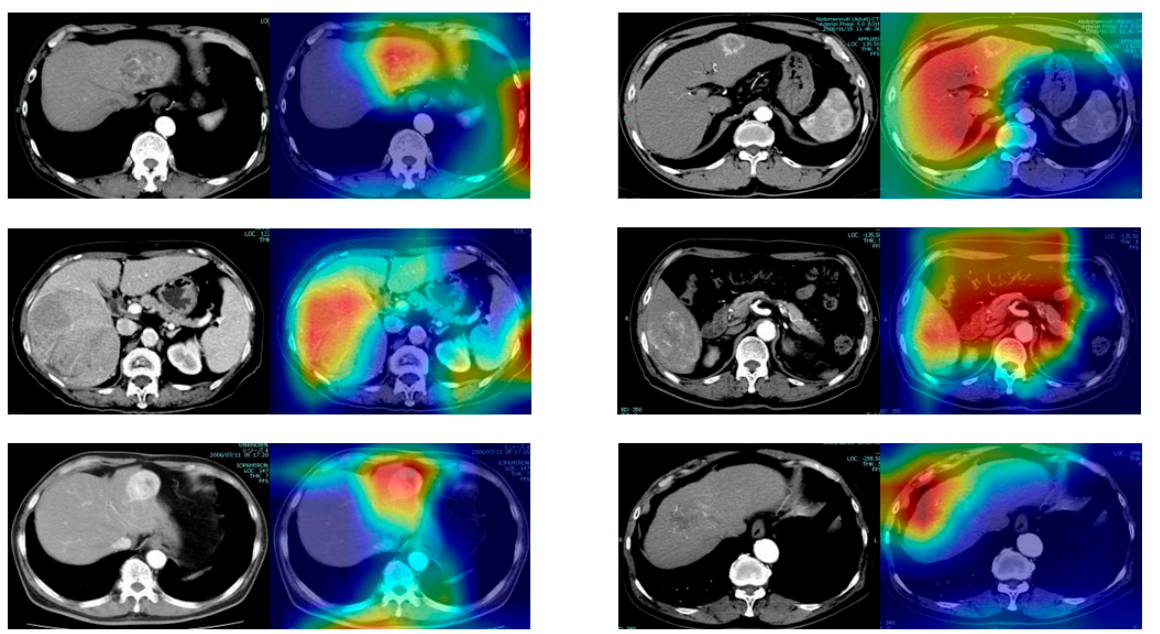
Figure 4. The original CECT images and their corresponding heatmaps are shown from left to right. The red color highlights the region of interest to predict early recurrence. CECT, contrast-enhanced computed tomography.